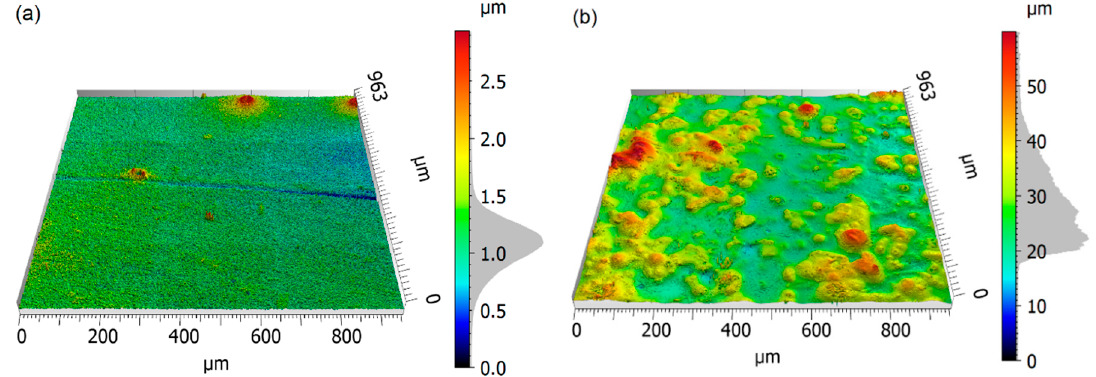
Figure 4. 3D-view of the surface topography of ( a ) S1 and ( b ) S2, recorded with the 3D optical surface metrology system Leica DCM8, in the focus variation mode and 10x magnification.